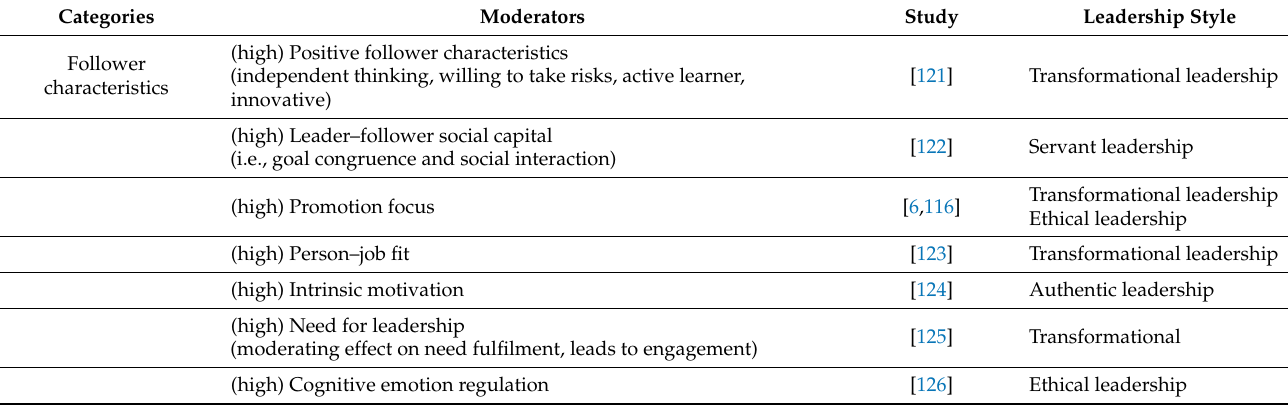
Table 4. Moderators of the relationship between positive leadership styles and engagement in empirical research. Between brackets the ‘amount’ of the moderator related to a higher employee work engagement.